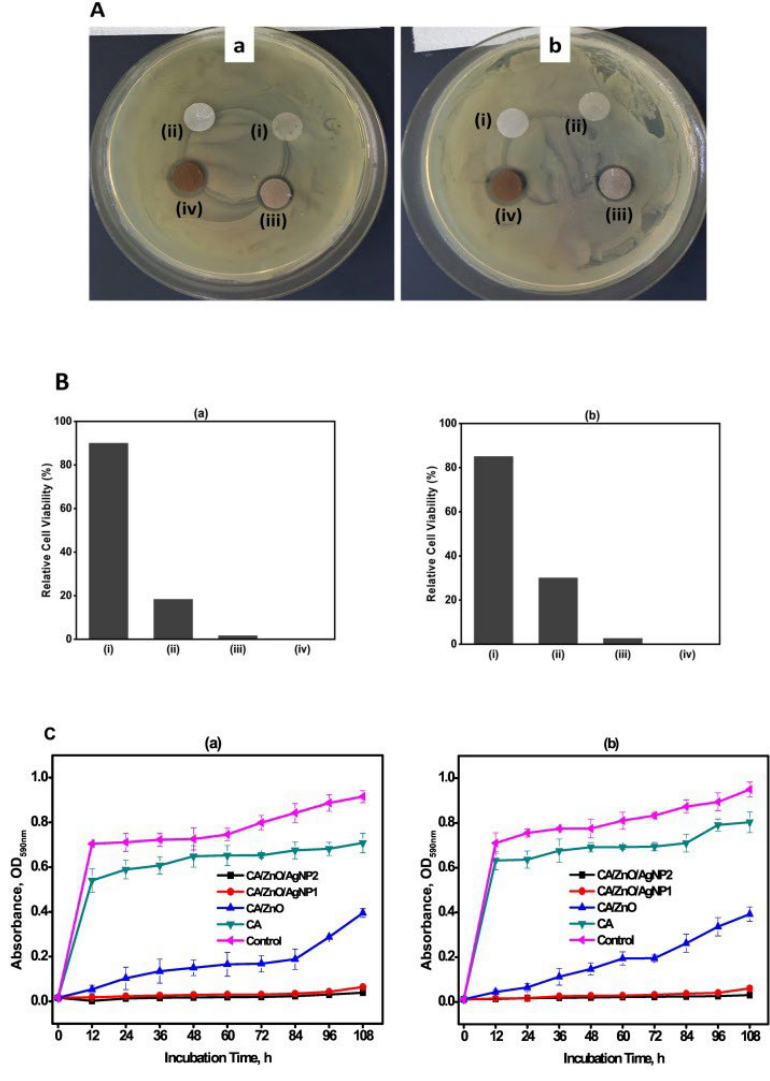
Figure 4. Antibacterial activity results. ( A ) Photographic images of disc diffusion test. ( B ) Bacteri- cidal assay. ( C ) Liquid medium bacteria growth inhibition of the samples (i) CA, (ii) CA/ZnO, (iii)